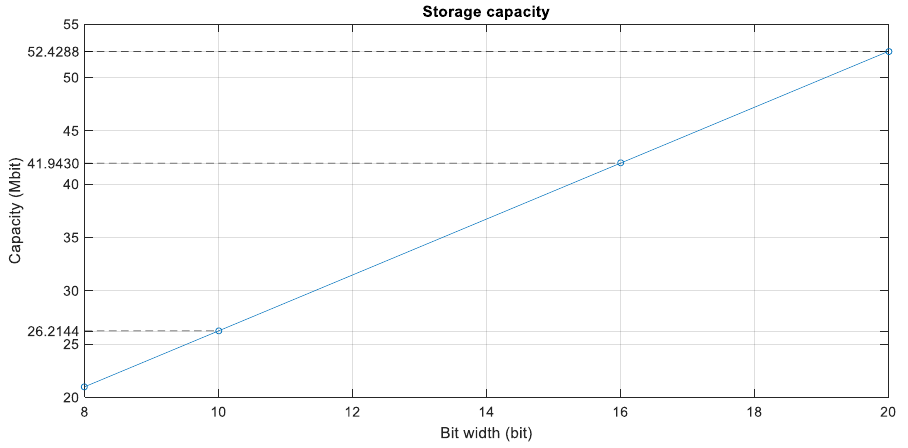
Figure 8. Variation of storage capacity as a function of the data-bit width.